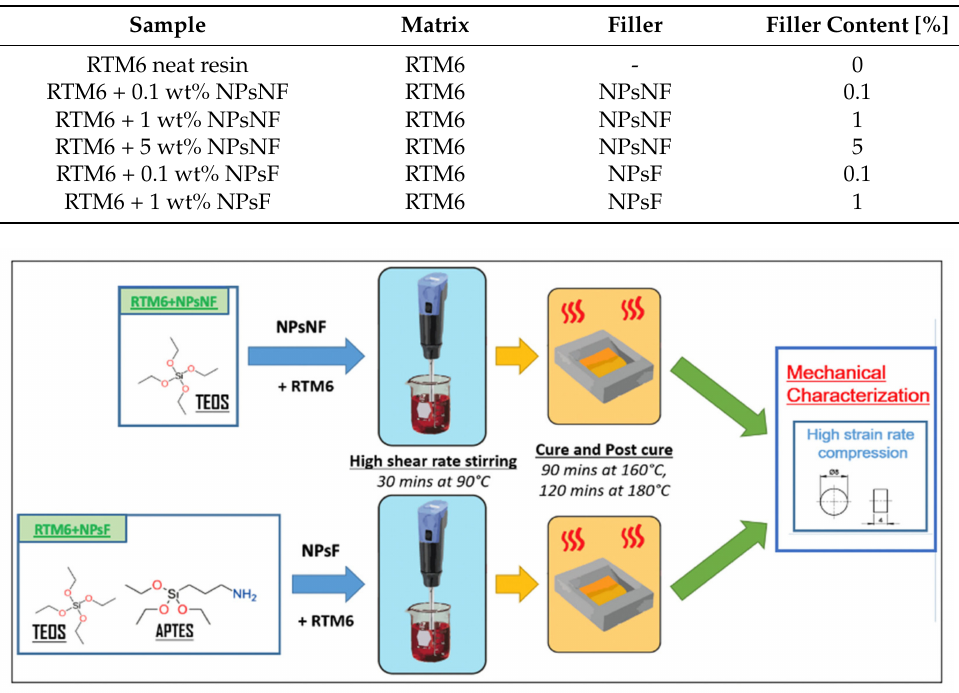
Figure 1. Manufacturing procedures of the silica/epoxy